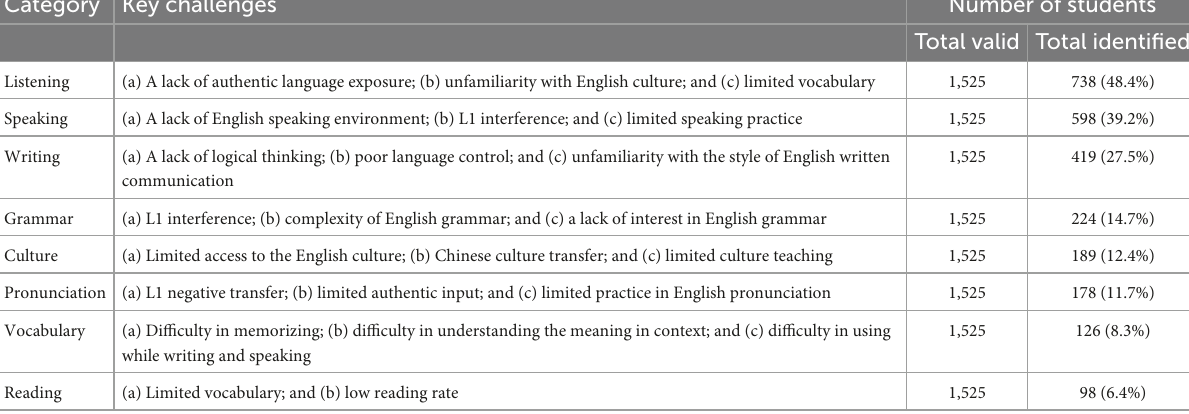
TABLE 3 Chinese college students’ key challenges in learning English. Category Key